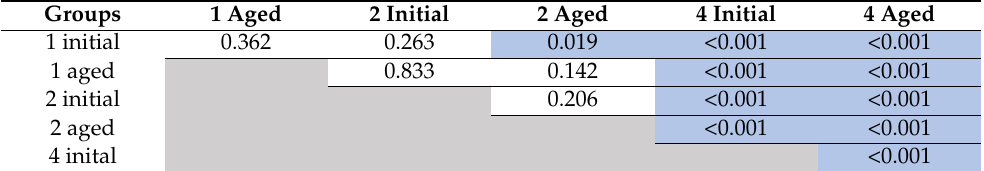
Table A1. Retention force: p -values (colored: significant